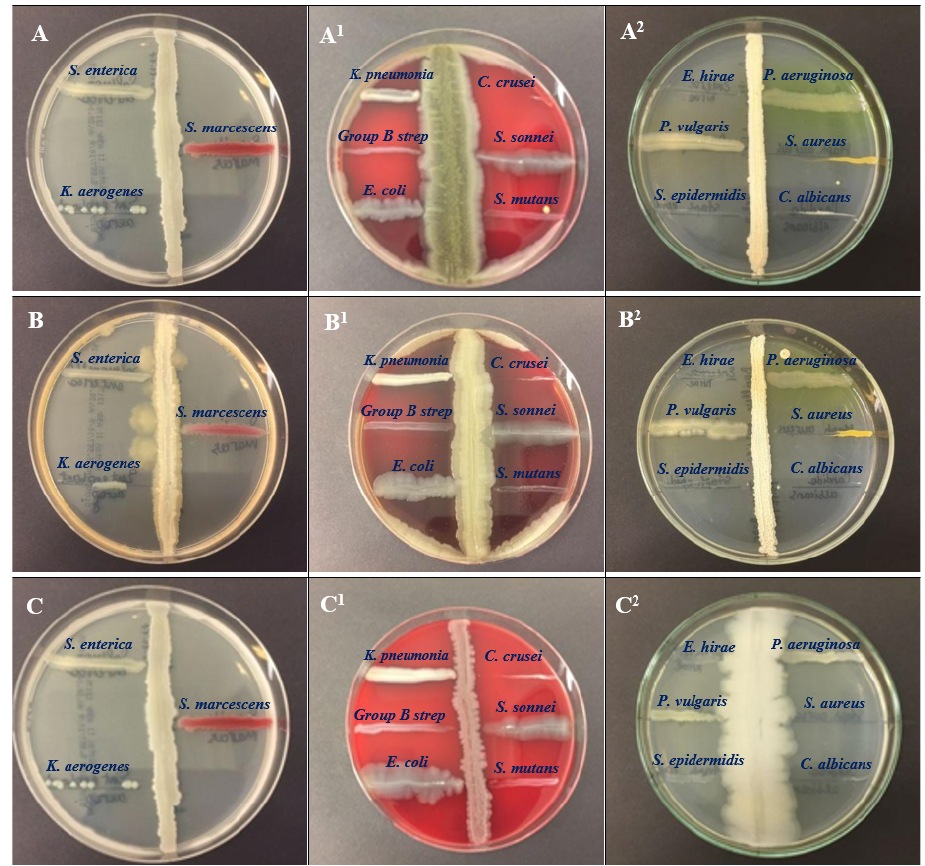
Figure 1. Antagonistic activity of the bacteria of the genus Bacillus against pathogens. Antagonistic efficacy of all three isolates was examined against pathogenic bacteria, such as Salmonella enterica ATCC 35664, Serratia marcescens ATCC 13880, Klebsiella aerogenes ATCC 13048, Candida krusei ATCC